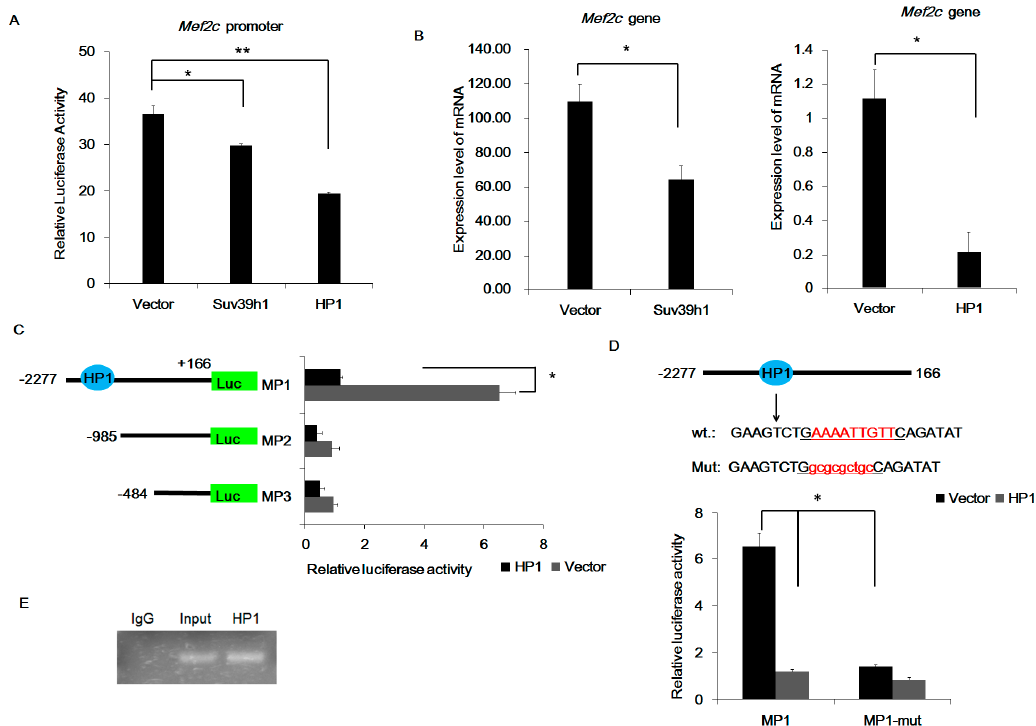
Figure 7. Inhibition of MEF2 transcriptional activity by Suv39h1 and HP1 α . ( A ) C2C12 cells were transiently co-transfected with expression vectors for Suv39h1 or HP1 α and Mef2c promoter vector. Firefly luciferase levels were normalized against Renilla luciferase levels. Bars represent the mean ± SD of three experiments. The statistical significance of the differences values was analyzed by Student’s t -test, * p < 0.05; ** p < 0.01; ( B ) C2C12 cells were transfected with expression vectors for Suv39h1 or HP1 α , and the expression of Mef2c was analyzed by qRT–PCR. The results were normalized against β -actin . Bars represent the mean ± SD of three experiments. The statistical significance of the differences values was analyzed by Student’s t -test, * p < 0.05; ( C ) Effects of HP1 α on Mef2c promoter activity. Promoter activities of a series of deleted constructs were determined by luciferase assay. The nucleotides were numbered from the potential transcriptional start site that was assigned as +1. Firefly luciferase levels were normalized against Renilla luciferase levels. Bars represented the mean ± SD of three experiments. The statistical significance of the differences values was analyzed by Student’s t -test, * p < 0.05; ( D ) The site-directed mutagenesis construct in the HP1 α binding site of the Mef2c promoter was analyzed by luciferase assay in C2C12 cells. Firefly luciferase levels were normalized against Renilla luciferase levels. Bars represent the mean ± SD of three experiments. The statistical significance of the differences values was analyzed by Student’s t -test, * p < 0.05; ( E ) Binding of HP1 α with the Mef2c promoter was analyzed by ChIP. DNA isolated from immunoprecipitated material was amplified by PCR. Total chromatin was used as the input. Normal rabbit IgG was used as a negative control.